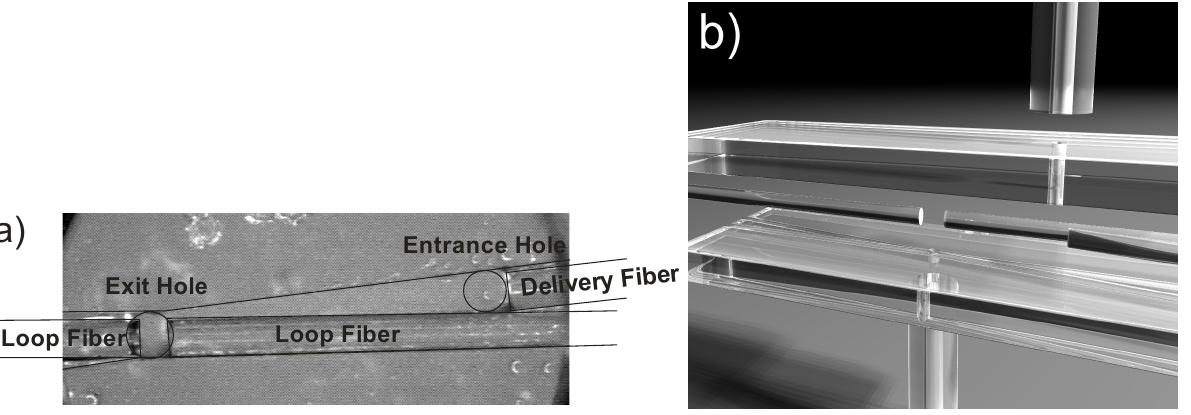
Figure 4. A custom interface is used to direct liquid between the fiber ends and to couple light from the light source into the loop. The delivery fiber irradiates the fiber loop ends so that some of the light enters the loop. The sample is injected through a hole in the top plate in front of the delivery fiber, flows along the groove to the gap between the fiber ends and exits through a hole in the bottom plate [20]. (a) Top view. (b) Computer generated schematic